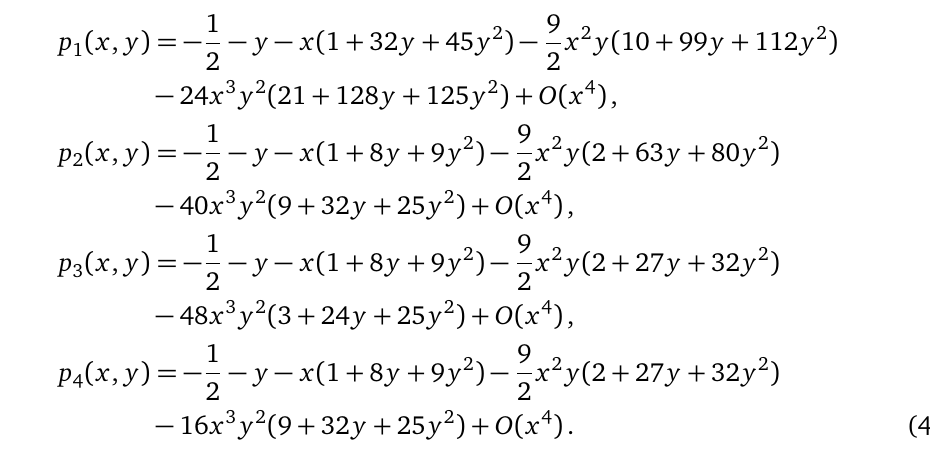
Table 6: Expressions for S ( 2,2 )